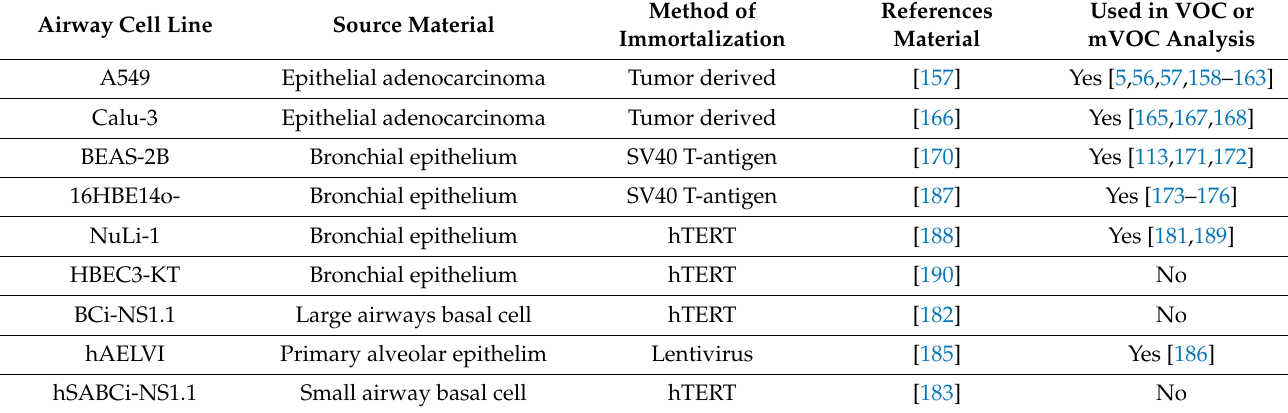
Table 2. Overview of respiratory cell lines and use in VOC or mVOC